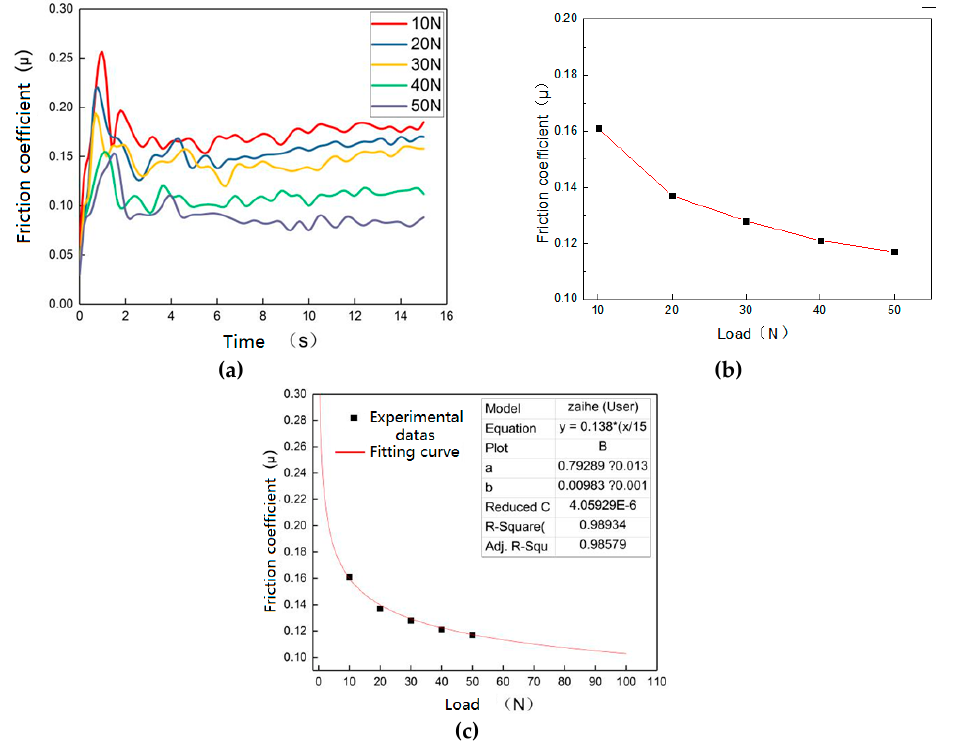
Figure 7. Friction coefficient curve under different loads: ( a ) Variation curves of the friction coefficient over time under different loads; ( b ) Experimental friction coefficients at different loads; ( c ) Fitting curve of the friction coefficient with load From the fitting, the values of a and b are 0.793 and 0.01, respectively, and the fitting degree is 0.9858, which shows that the model can better reflect the variable relationship between the load and friction coefficient. The functional relationship between the friction coefficient and interface load is as follows. 01.015/138.0 207.0 += − ）（ F μ Five groups of normal loads of 15, 25, 45, 55 and 65 N were selected in order to verify the validity of the model. The values of the five groups of normal loads were substituted into Equation (9). The actual measurement and function prediction calculation results are shown in Table 4. Table 4. Friction coefficient measurement and function model prediction.